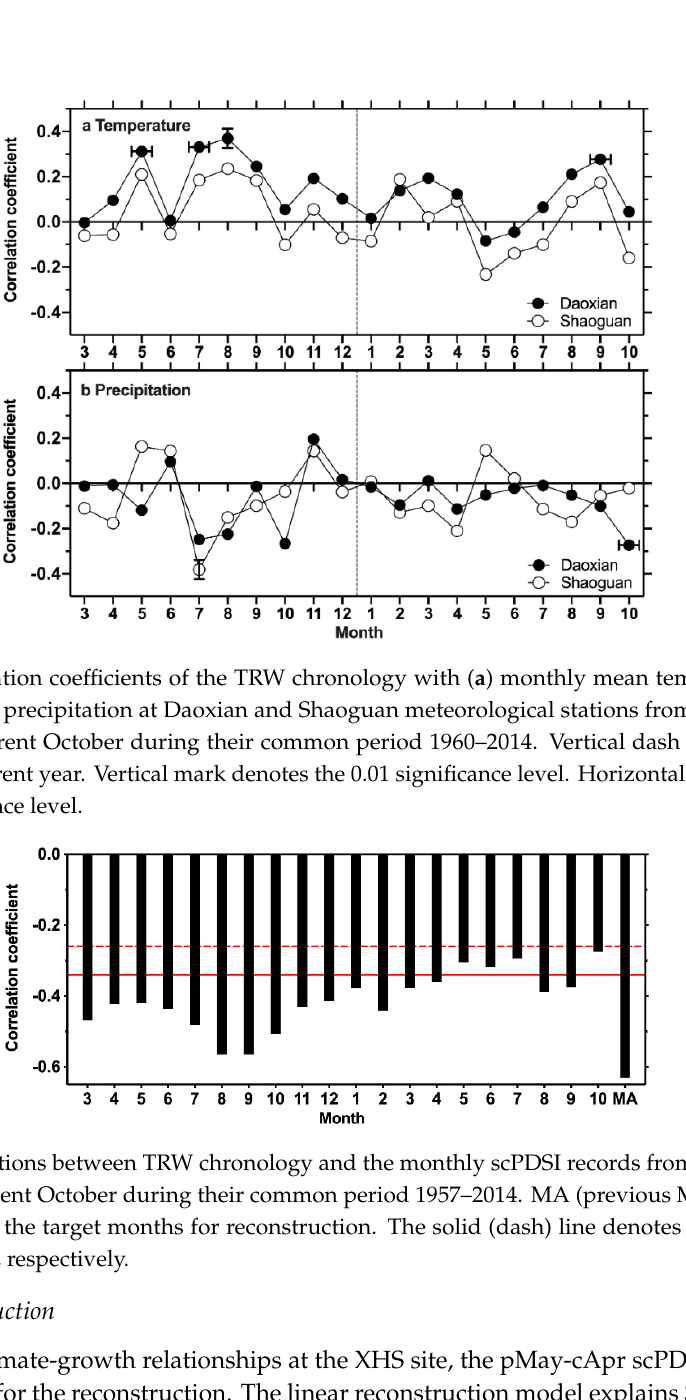
Figure 6. Correlations between TRW chronology and the monthly scPDSI records from the previous March to the current October during their common period 1957–2014. MA (previous May to current April) represents the target months for reconstruction. The solid (dash) line denotes the 0.01 (0.05) significance level, respectively.